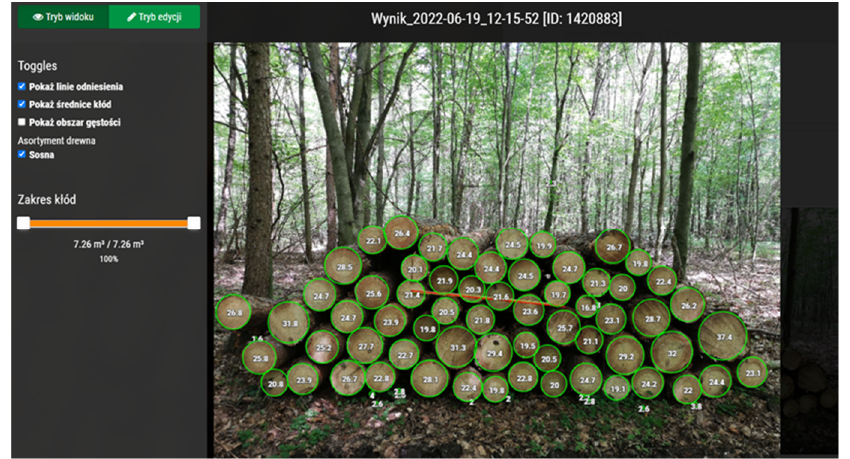
Figure 1. Identification of a stacked wood polygon by the iFovea application. (Fot. W. Sarzyński).